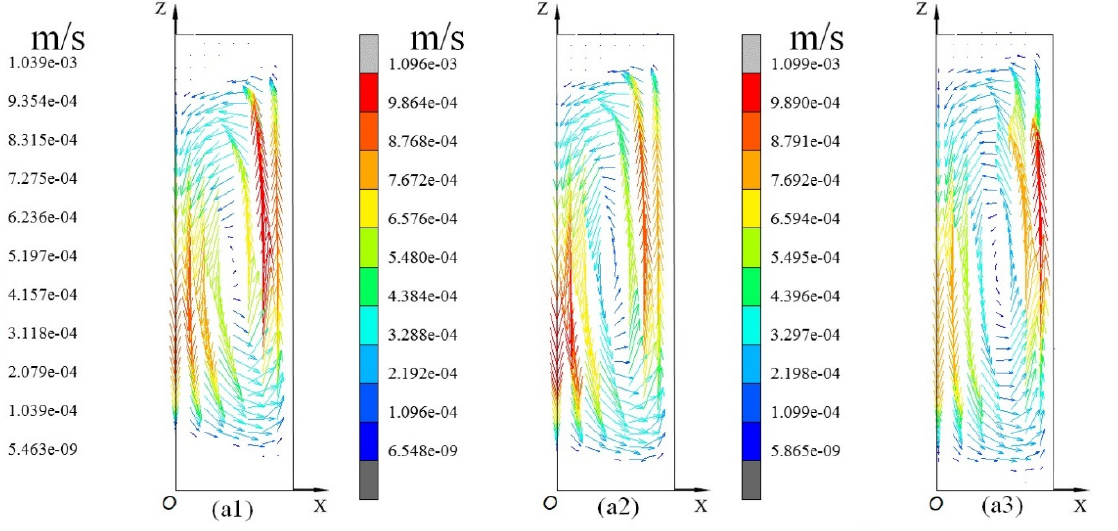
Figure 6. The vector graphs of fluid flow when the melting zone is 0.08–0.12 m from the bottom of the crucible. ( a1 ) crystal radius 0.01 m, the maximum furnace temperature 1030 K; ( a2 ) 0.01 m, 1040 K; ( a3 ) 0.01 m, 1050 K; ( b1 ) 0.015 m, 1030 K; ( b2 ) 0.015 m, 1040 K; ( b3 ) 0.015 m, 1050 K; ( c1 ) 0.02 m, 1030 K; ( c2 ) 0.02 m, 1040 K; ( c3 ) 0.02 m, 1050 K.